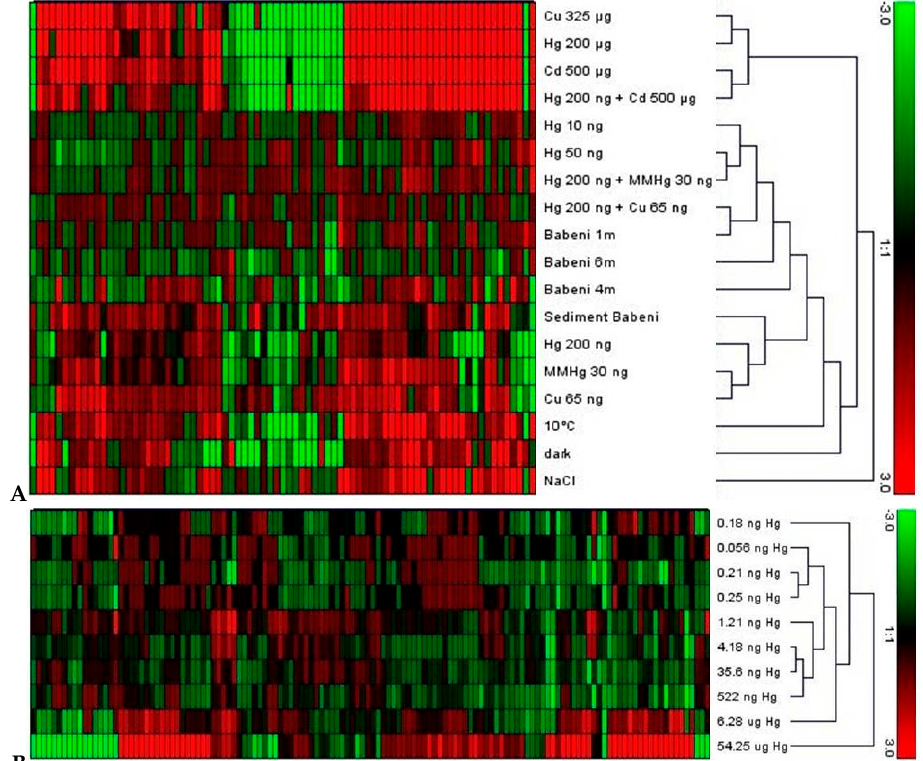
Figure 2. ( A ) Clustering of differentially expressed genes as revealed by nCounter analysis. Elodea nuttallii were exposed in the laboratory to various metal concentrations (where MMHg is monomethyl-mercury), to Hg contaminated sediment collected in the Olt river in Romania (Sediment Babeni), and to other abiotic factors temperature, darkness, and salinity (NaCl). A set of plants was exposed in the Olt river at 1, 4, and 6 m water depth (Babeni 1 m, 4 m, 6 m). Hierarchical clustering with average linkage was performed using Genesis software; ( B ) Clustering of differentially expressed genes in response to gradually increasing effective Hg concentration in controlled conditions. Gene signature was positively correlated with Hg concentration from 1 pM (0.2 ng·L − 1 ) (the figure was adapted from the original data and figure in [62]).